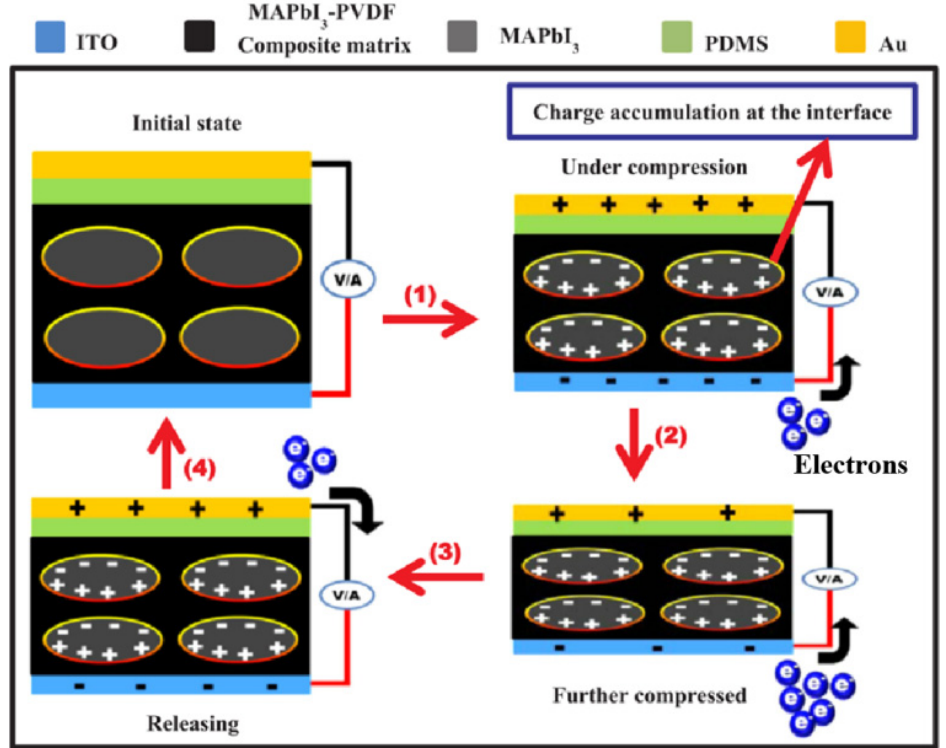
Figure 2. Schematic of the working mechanism of MAPbI 3 –PVDF composite piezoelectric nanogenerators (PENGs) [40]. Reproduced with the permission from reference [40].